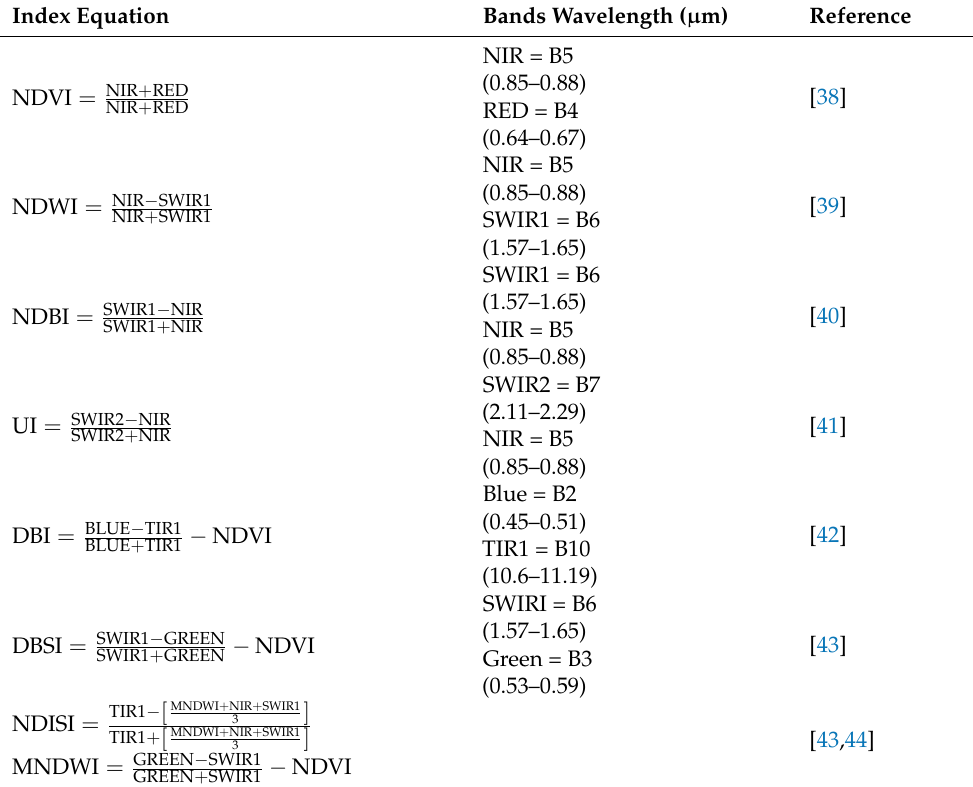
Table 2. Various indices and their respective bands are derived from Landsat-8